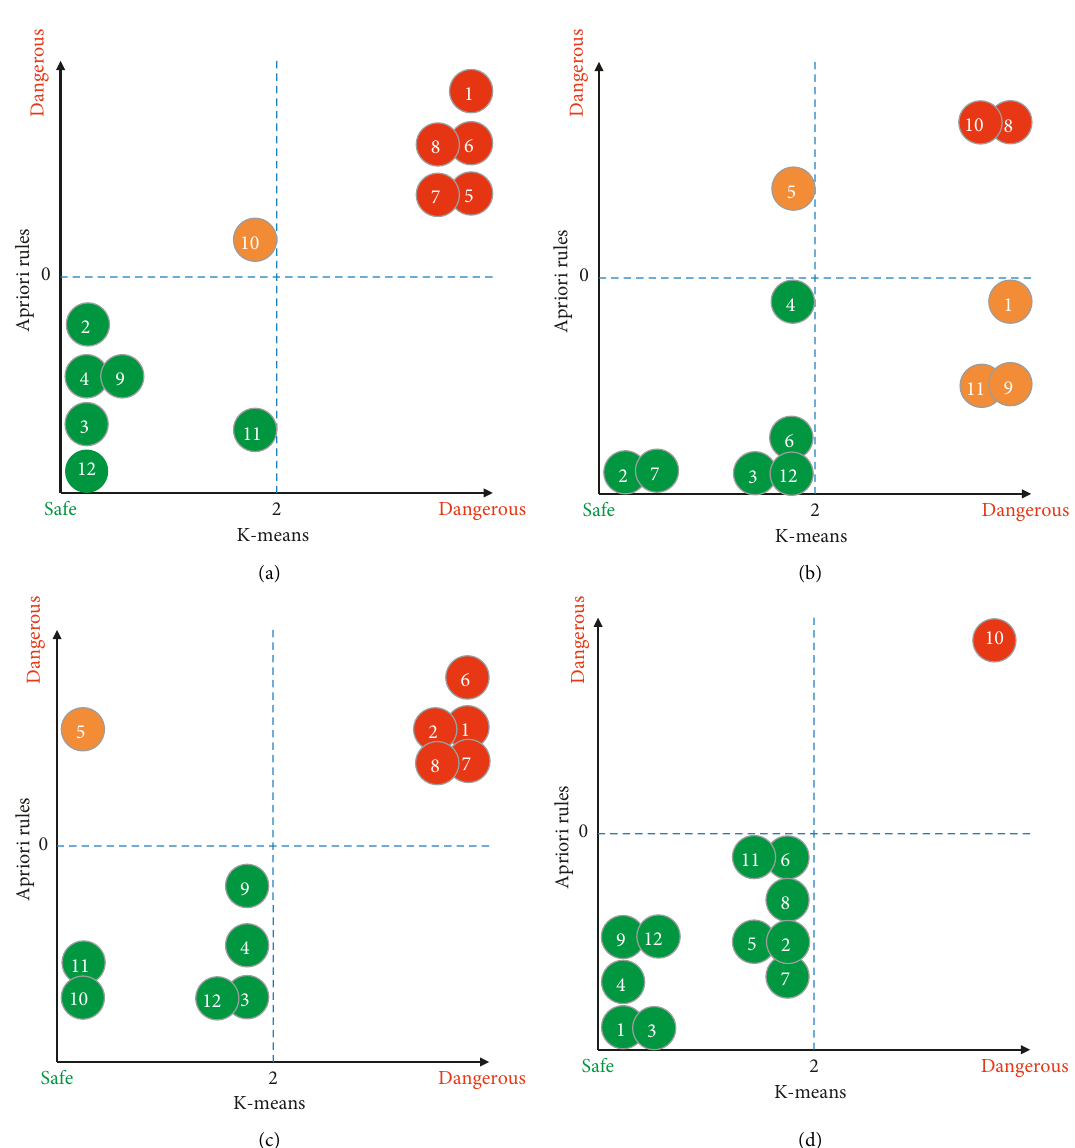
Figure 7: Monthly risk distribution: (a) total number of crashes, (b) rear-end, (c) fixed-object hitting, and (d) overturning (if two or more months overlap, it means they have the same risk